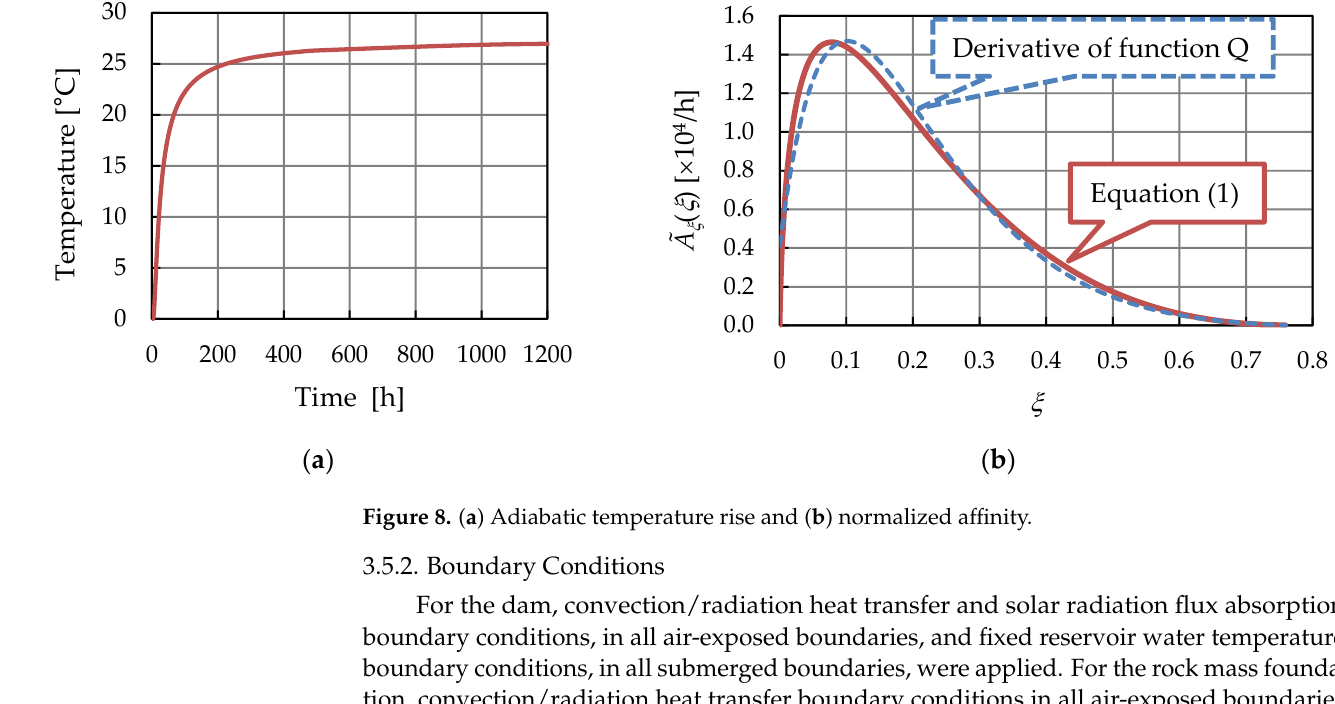
Figure 8. ( a ) Adiabatic temperature rise and ( b ) normalized affinity.